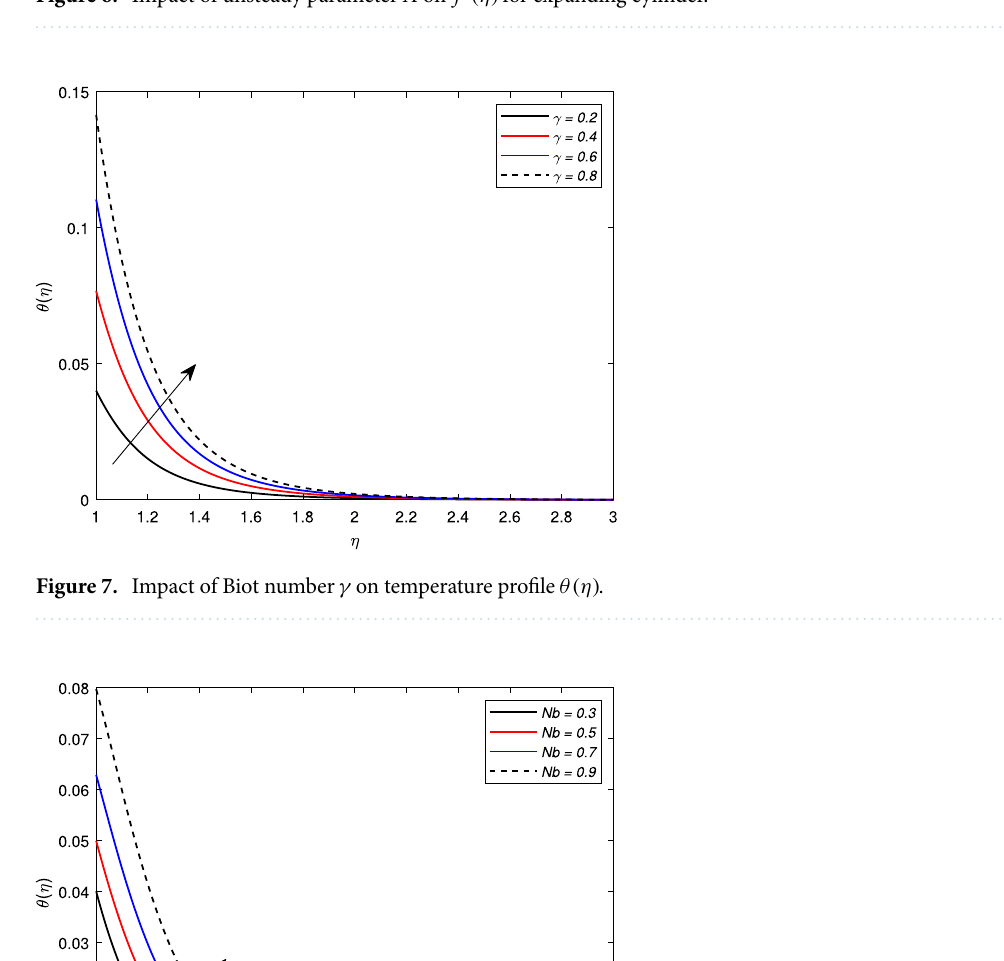
Figure 6. Impact of unsteady parameter A on f ′ (η) for expanding cylinder.